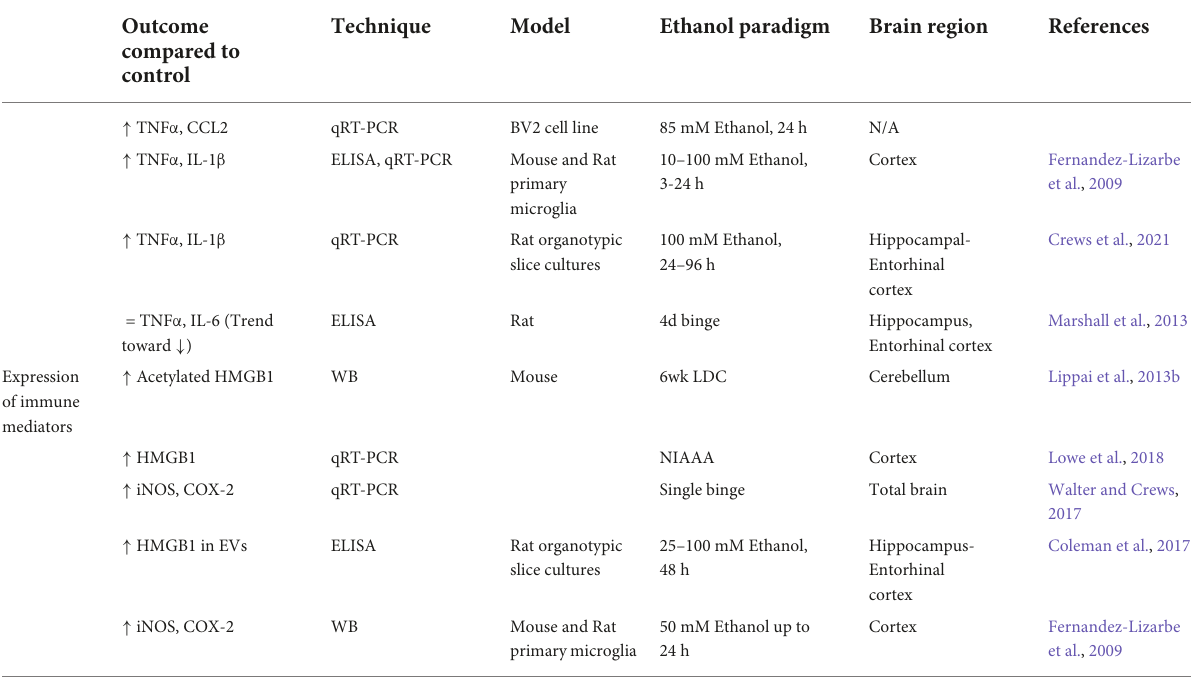
IF-Immunofluorescence.